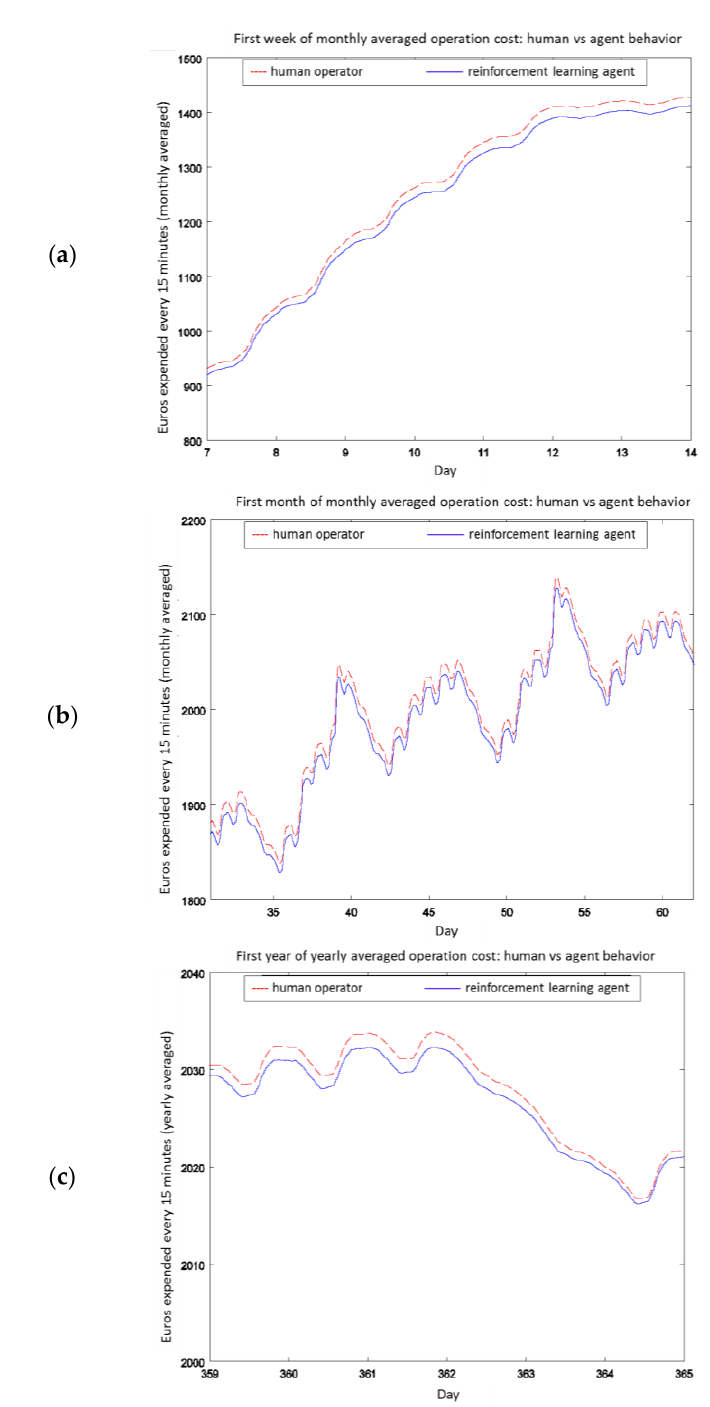
Figure 9. ( a ) Monthly cost after the first week of learning; ( b ) monthly cost after the first month of learning; ( c ) yearly cost after one year of learning.